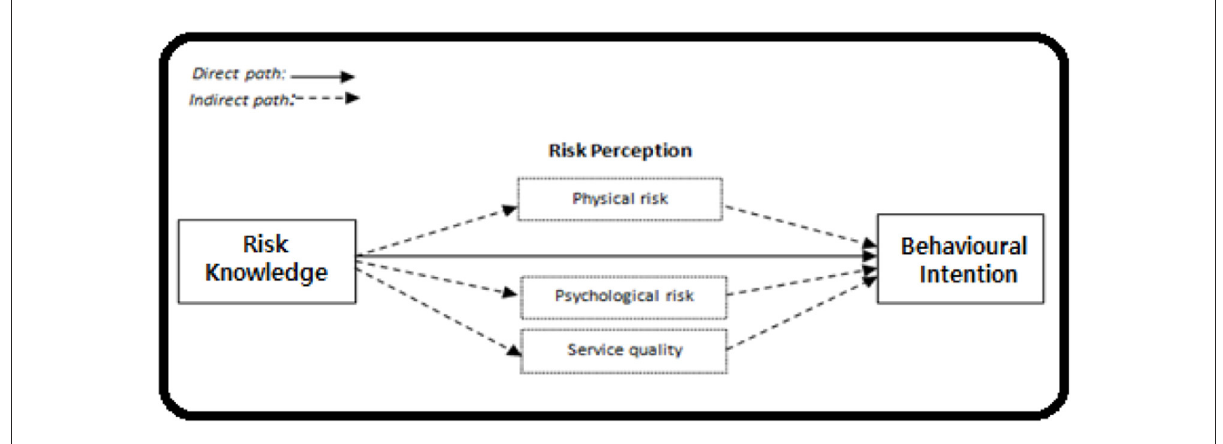
FIGURE2 Conceptual model of the